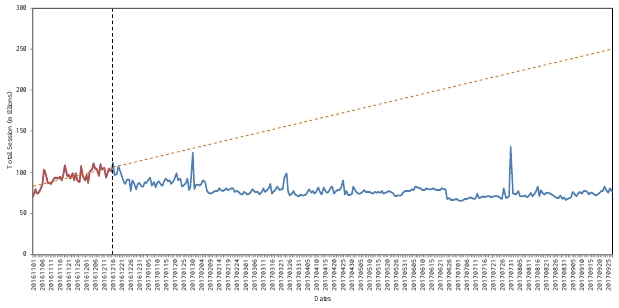
Fig. 20. PT. ZYX CGNAT NAT table